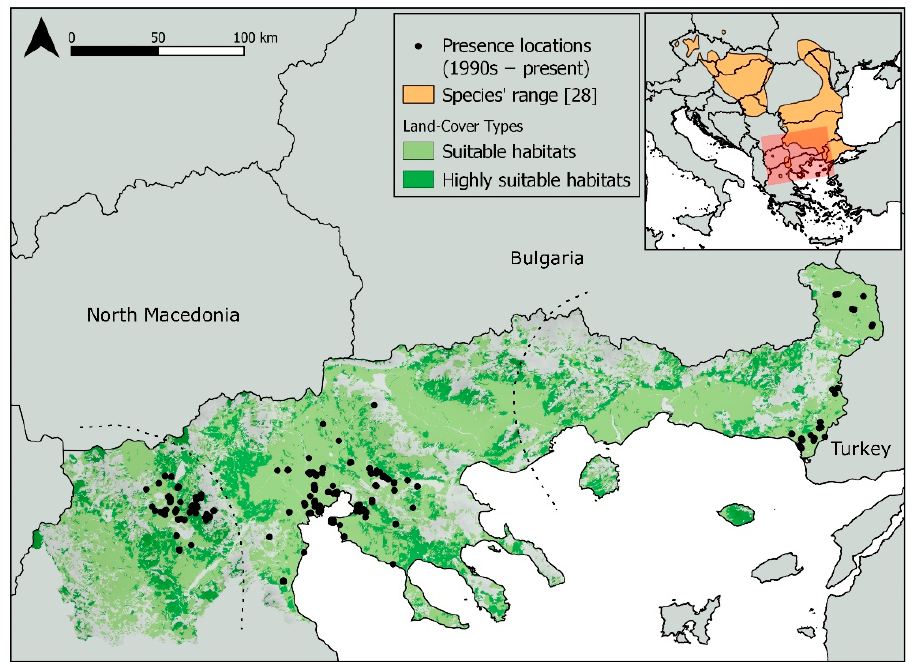
Figure 1. The distribution of the presence records (1990 − 2021) of Spermophilus citellus in Northern Greece. The suitable habitats of the species in the study area are schematically marked in green (light green for suitable and dark green for highly suitable habitats, please see Table 1 for more details), and the unsuitable habitats are in grey. Habitat suitability was assessed based on ecological criteria from [17,19]. Dashed lines separate the three sub-populations of Western Macedonia ( left ), Central Macedonia ( center ), and Thrace ( right ).